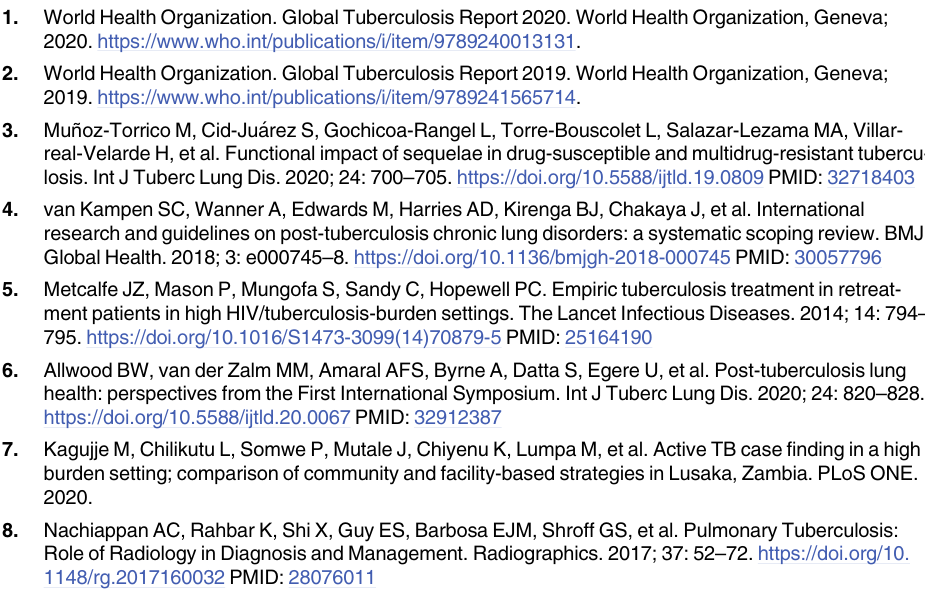
S4 Table. Overview of chest radiography characteristics among presumptive TB patients with a prior history of TB, without evidence of current TB disease (confirmed or possible), according to HIV status (n =